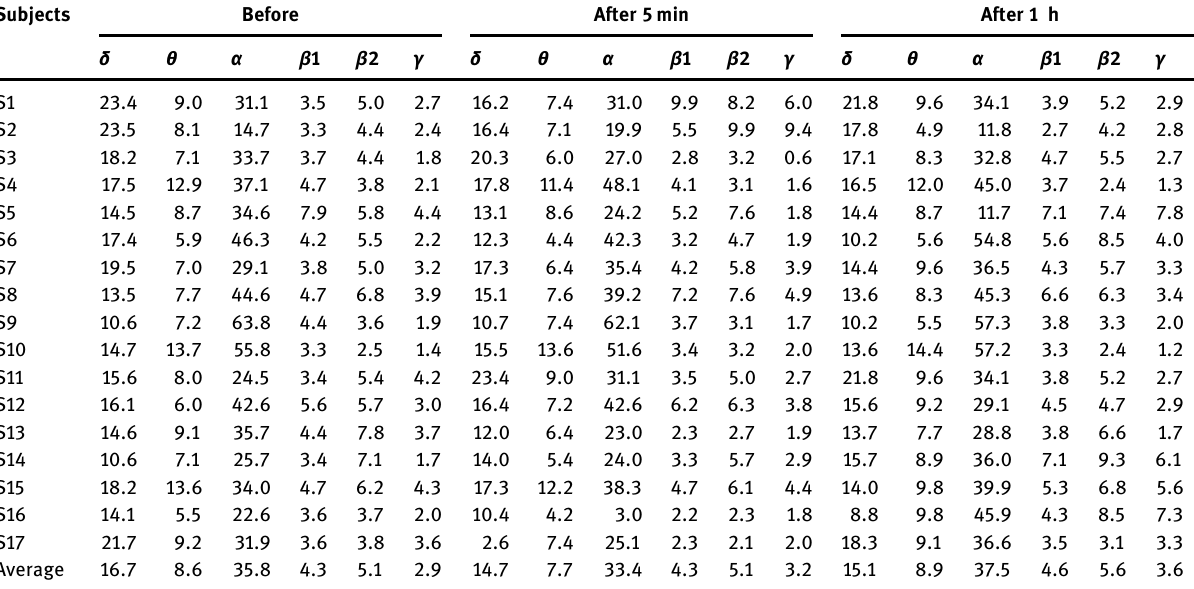
Table 3: Pre: Amplitude of each channel of each brain wave